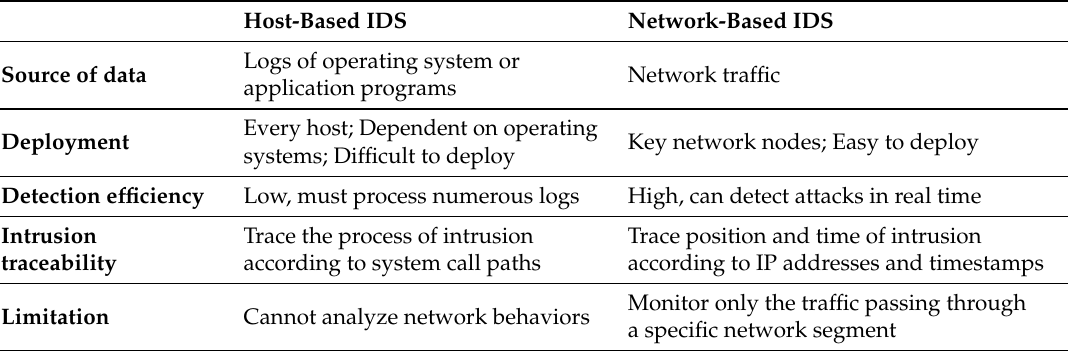
Table 2. Differences between host-based and network-based